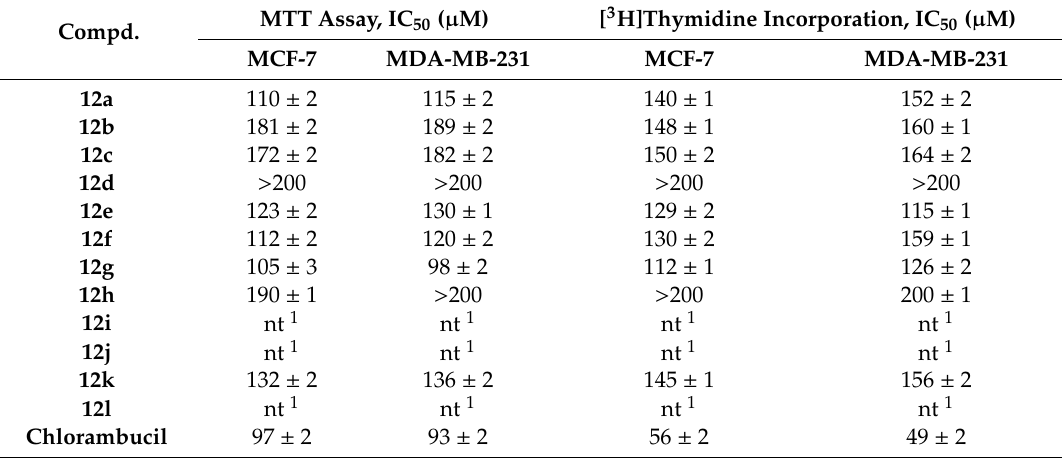
Table 5. Cytotoxic and cytostatic activities of new sulfonamides derivatives of pyrazolo[4,3- e ][1,2,4]triazines 12a – l after 24 h incubation. Compd.